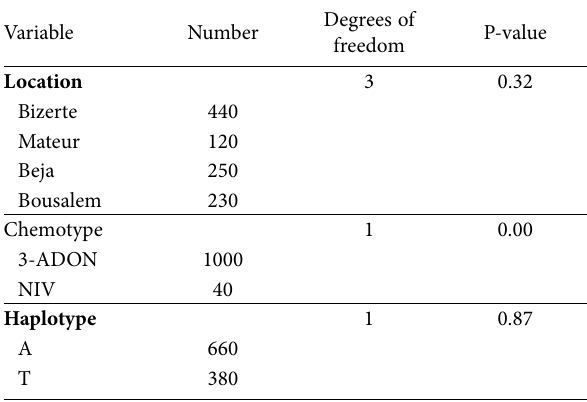
Table 2. Statistical significance of impacts of location, chemotype or haplotype on pathogenicity of Fusarium isolates associated with root rot of wheat.